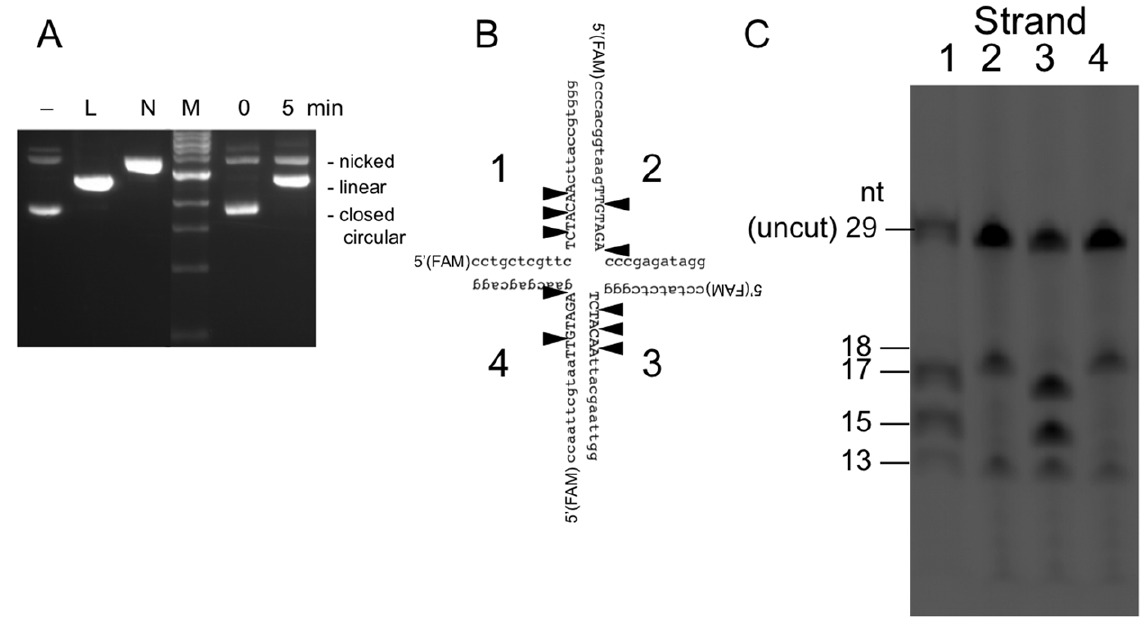
Figure 2. SIRV2 Hjr cleaves four-way DNA junctions. (A) Cleavage of plasmid pUC(AT) by Hjr was monitored over time by agarose gel electrophoresis. The mobility of nicked pUC(AT) was established by treating the plasmid with the nicking enzyme Nt. BstNBI (Lane N), and that of the linear form by digestion with HindIII (Lane L). The NEB 1 kb DNA ladder (M) was used as a reference. (B) A four-way junction sequence and structure is shown with uppercase nucleotides correspond to native SIRV2 sequence. Strands are designated 1–4. SIRV2 Hjr cleavage sites are noted by triangles. (C) A four-way junction DNA substrate corresponding to the SIRV2 concatamer junction sequence (shown in B) was constructed by annealing four oligonucleotides, three unlabeled and one FAM-labeled; differently-labeled substrates are designated 1, 2, 3, or 4. MBP-Hjr was incubated with these (Lanes 1–4 respectively) at 55 u C for 1 hour in 1 6 ThermoPol Buffer. Reaction products were separated by denaturing 20% PAGE and quantified using a phosphoimager. Fragment sizes are